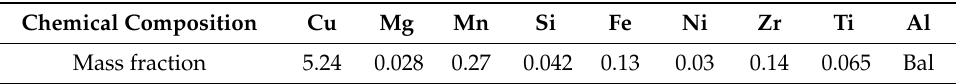
Table 1. Main chemical constituents of 2219 aluminum